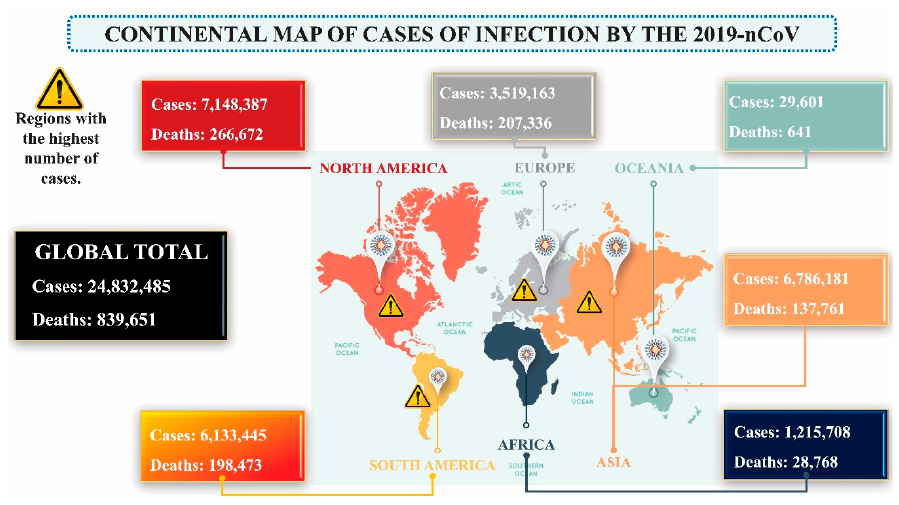
Figure 1. Continental map of SARS-CoV-2 infection cases. Data were collected on 28.08.2020 [15]. Designed by Freepik.